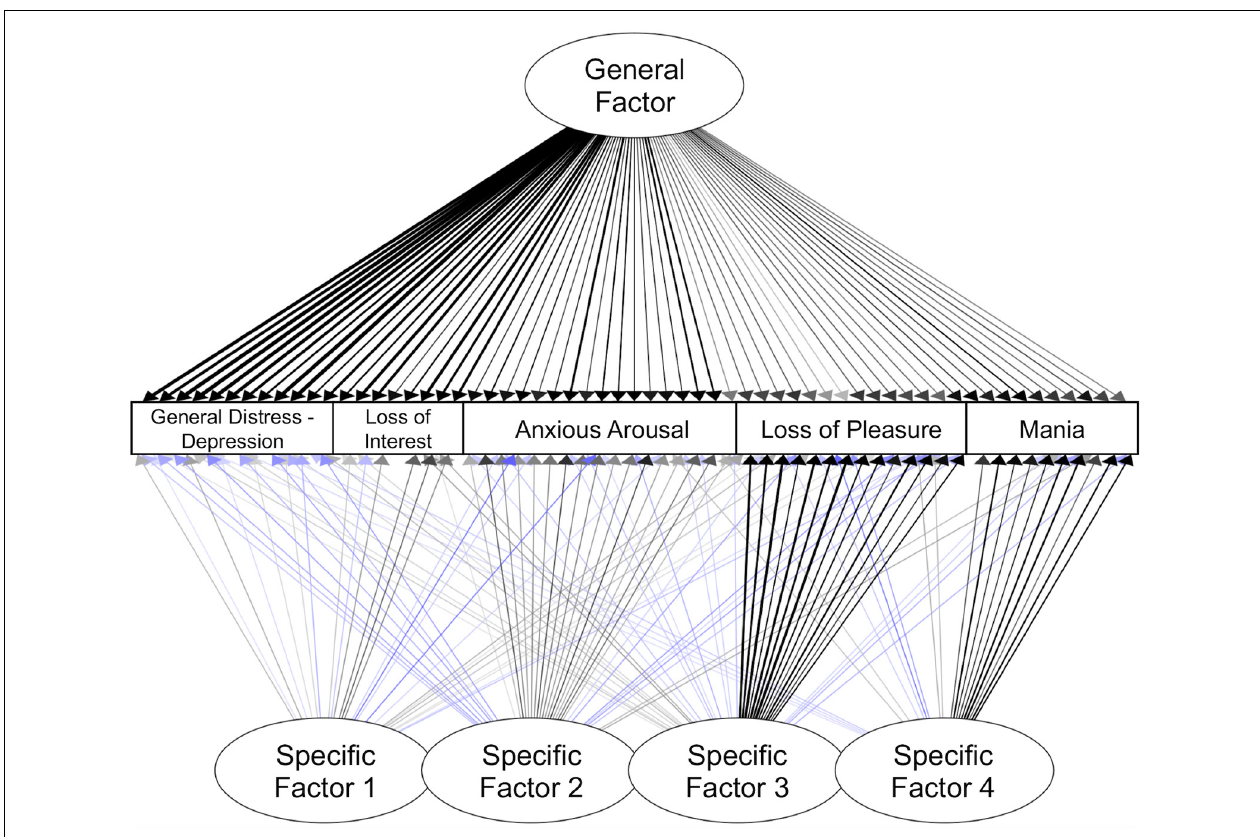
FIGURE 4 | Exploratory bifactor model of symptoms. Standardized estimates shown. Only significant paths are shown here ( p s < 0.05). Blue lines indicate negative loadings. Darker lines indicate loadings with a larger absolute